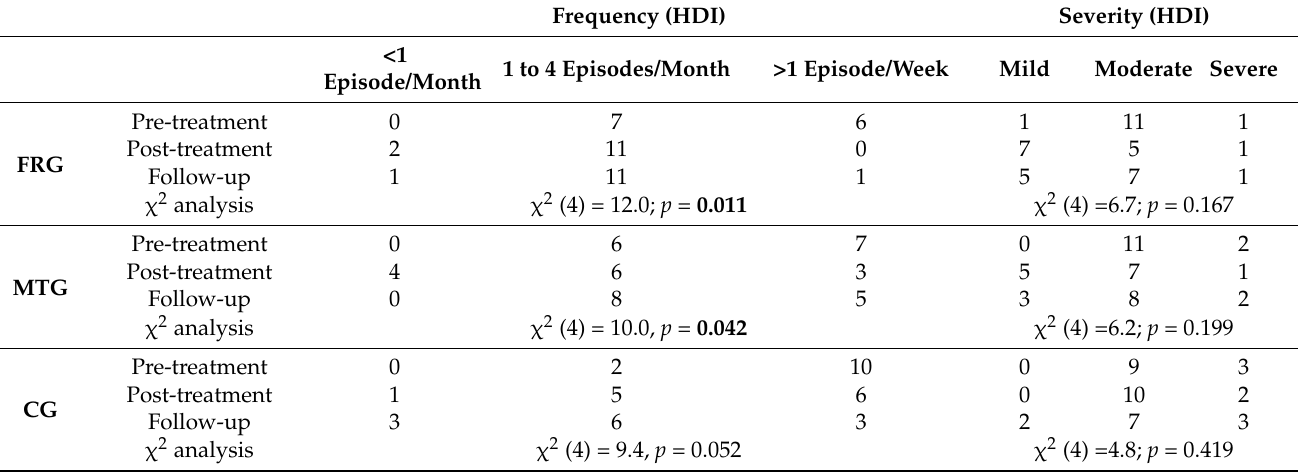
Table 6. Effects of the treatments on frequency and severity of headache disability. Frequency (HDI) Severity